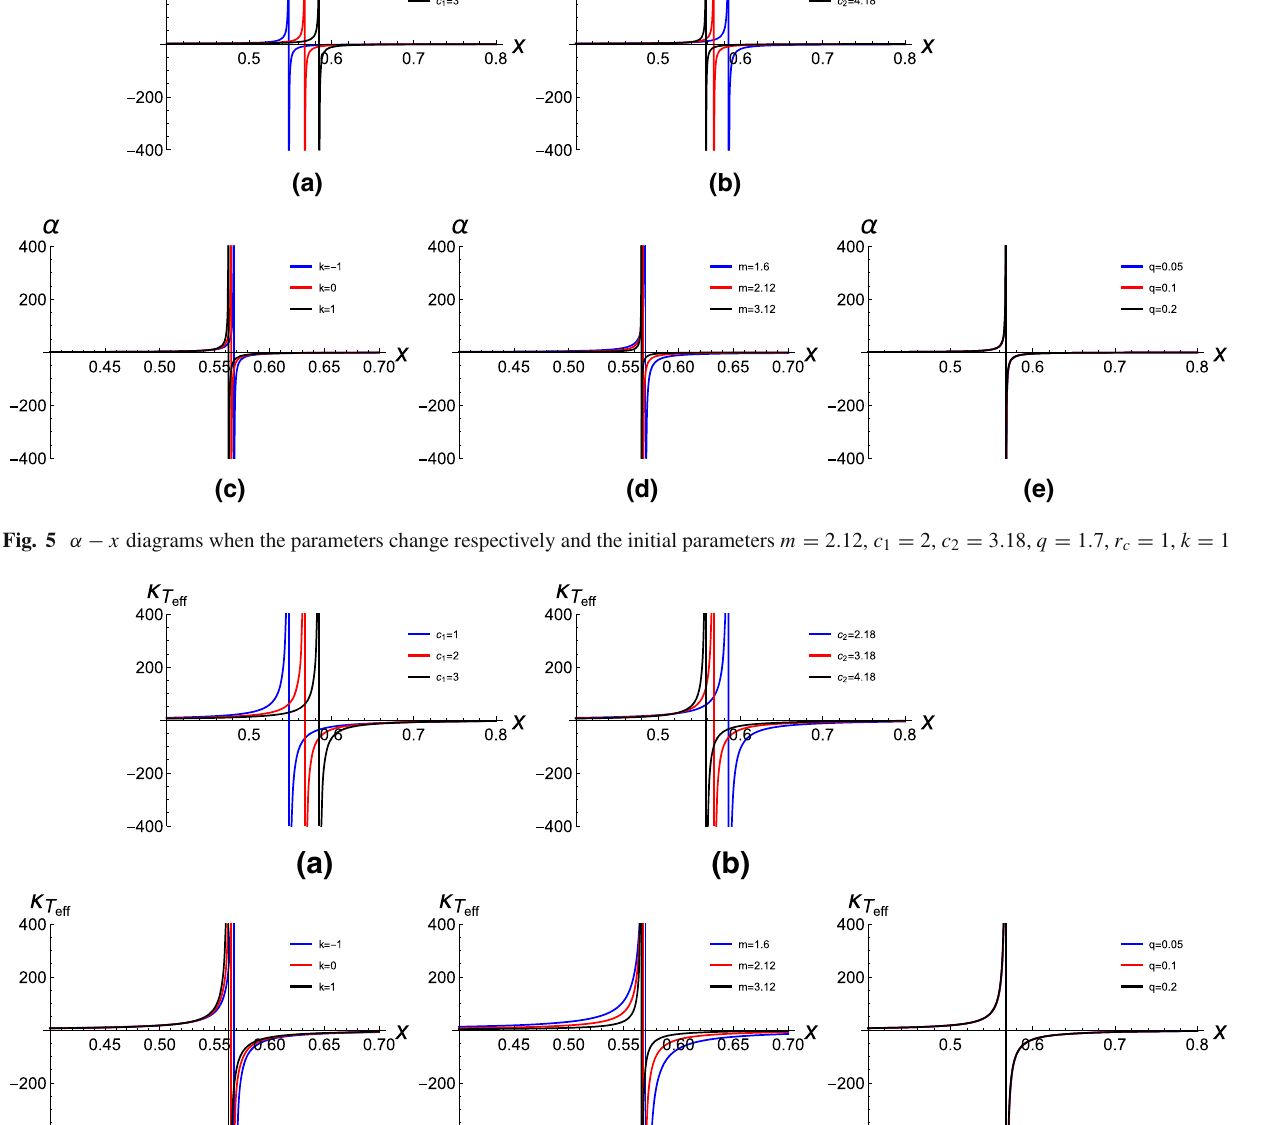
= 2, c = 3 . 18, q = 1 . 7, r 1 2